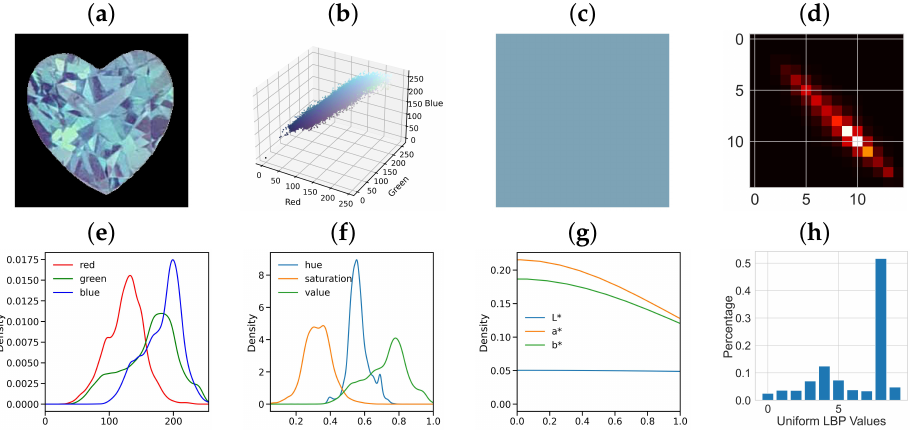
Figure 7. Illustration of colour and texture features extracted from a representative image. ( a ) Masked image of Alexandrite. ( b ) Scatter plot of the RGB values of all pixels. ( c ) RGB colour of the centre of the non-background K-means cluster. ( d ) GLCM matrix with an offset of 1 and angle of 0 ( e ) RGB histogram. ( f ) HSV histogram. ( g ) CIELAB histogram. ( h ) LBP